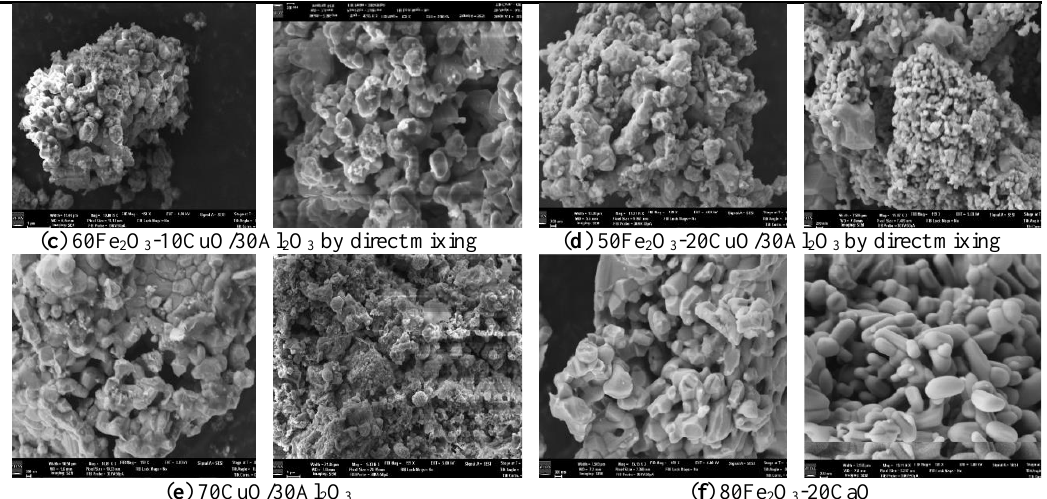
Figure 1. SEM images for fresh and used oxygen carriers.